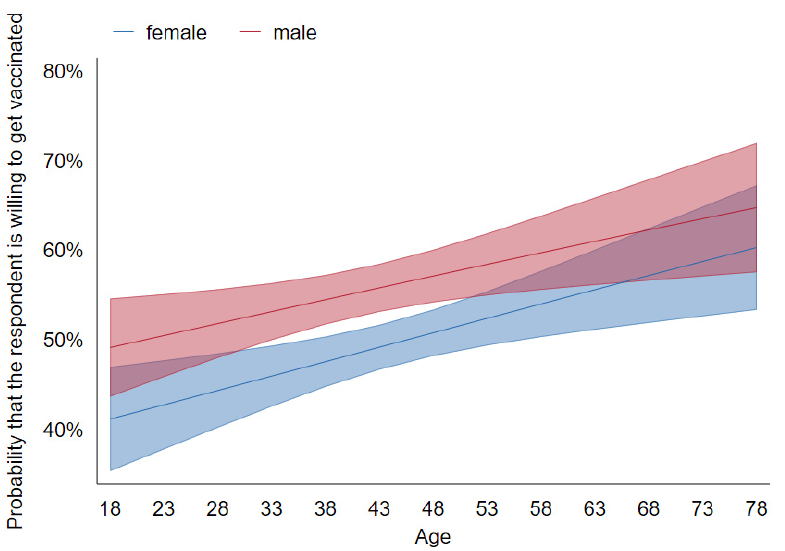
Figure 1. Predictive margins of sex and gender on vaccination decision with 95% confidence intervals (CIs; Wave 1).